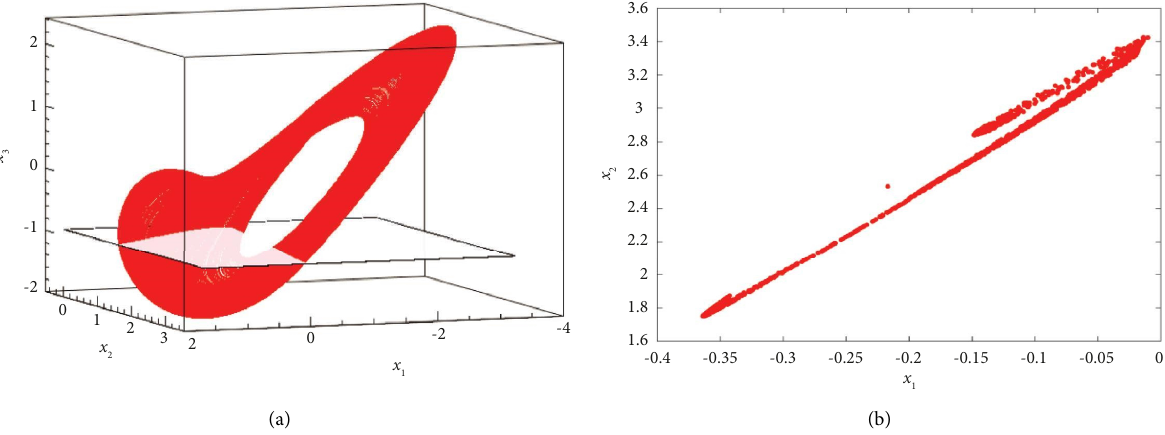
Figure 5: Poincar´e section of phase diagram of the system. (a) x